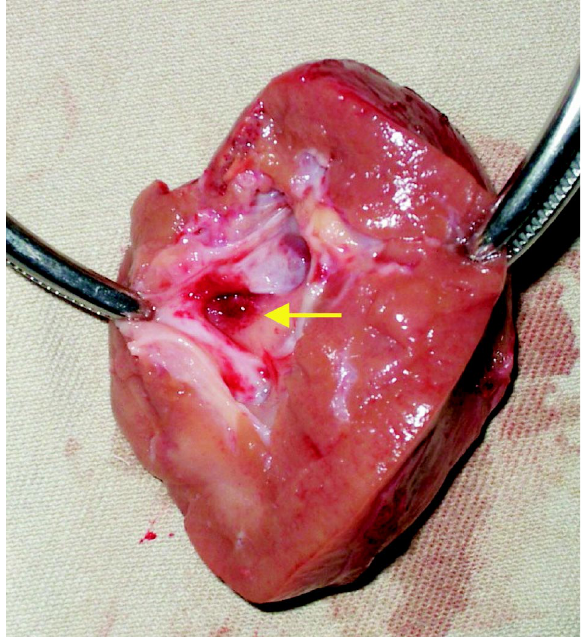
Figure 3 – The macroscopic surgical specimen revealed a lesion measuring approximately 0.5 cm in the upper calix of the right kidney